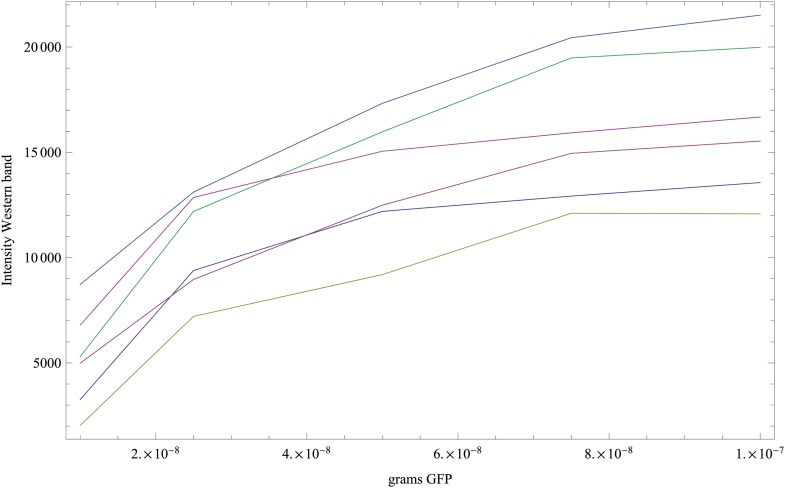
Measured intensities of the GFP reference bands as a function of the amount of GFP (in grams) loaded on each band.Each curve corresponds to one replicate (shown in a separate color), and each curve has five data points.